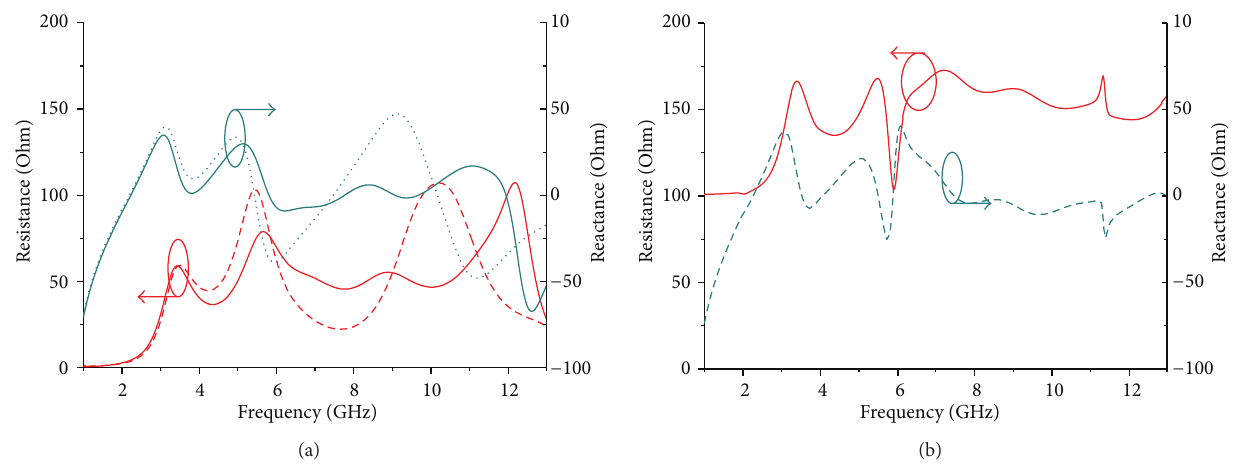
Figure 6: Frequency behavior of the real part of the antenna input impedance: (a) antenna without the band notch for different values of the parameter W2 , solid line: W2 = 13mm and dash line: W2 = 16mm (other parameters: G = 1mm, L2 = 11mm, Lg = 9mm, L2 = 5 mm, W1 = 20 mm, d1 = 0, and d2 = 0,) and (b) antenna with the band notch (other parameters: Lv1 = 13.5 mm, Lv2 = 0mm, Ln = 4 mm, S = 0.2 mm, and Ws = 1mm).